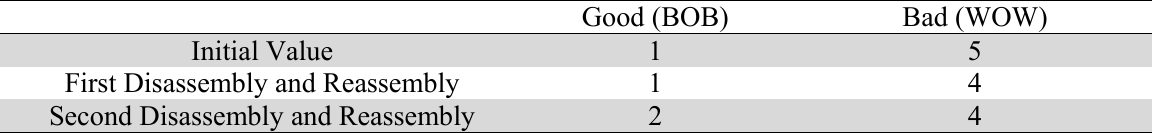
Response of Modified Component Search